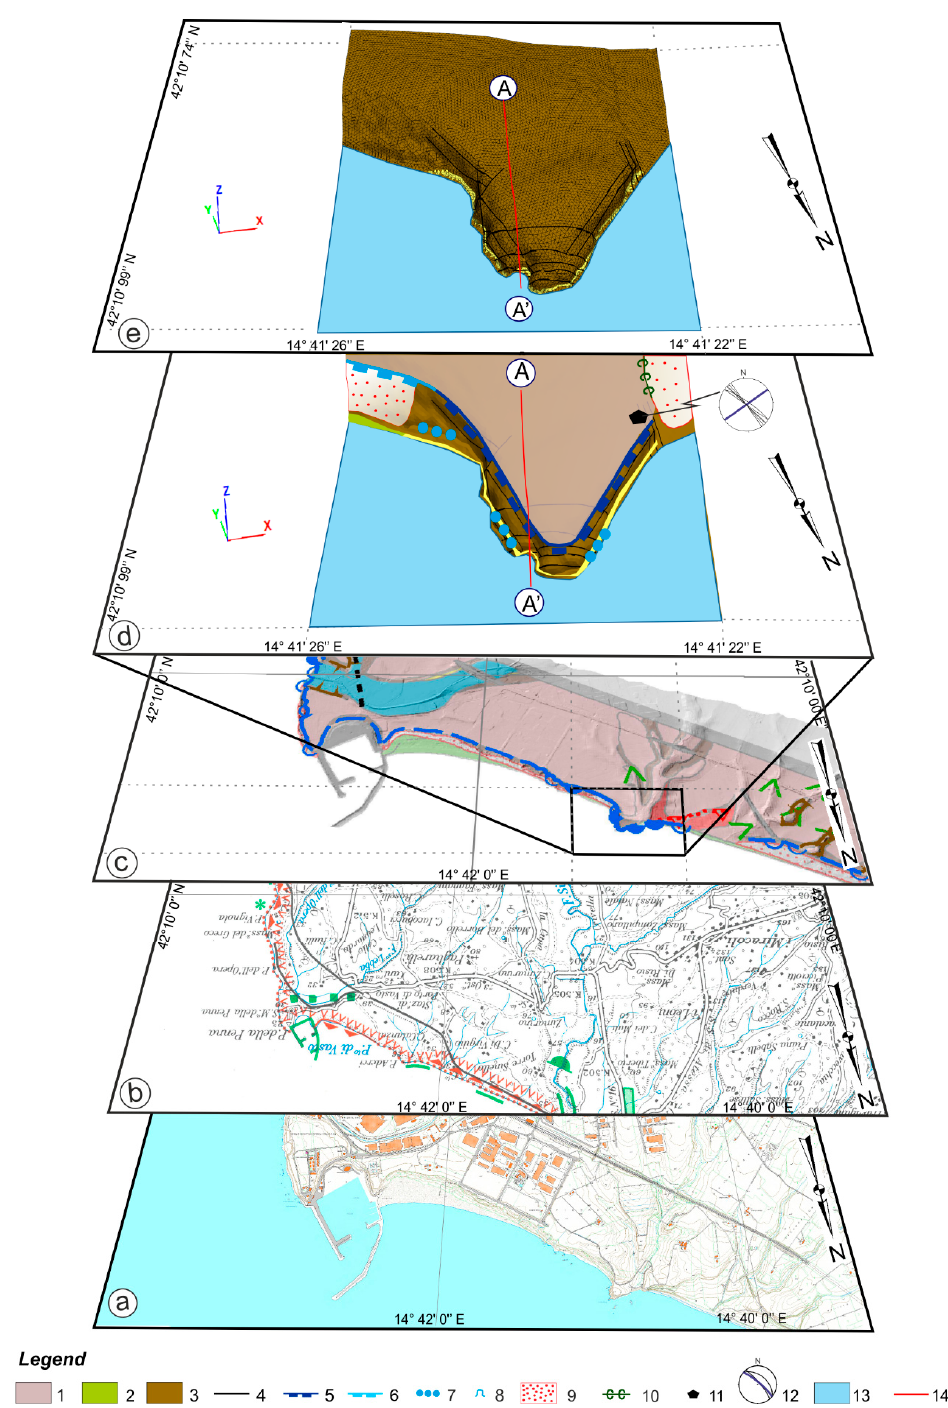
Figure 3. Methodological workflow for the reconstruction of the geological–geomorphological 3D models. ( a ) topographic map; ( b ) CNR atlas of beaches; ( c ) geomorphological map; ( d ) 3D real model; ( e ) 3D simplified model. Legend: 1. Colluvial, eluvial deposits; 2. Beach deposits; 3. Conglomerate with sandstone lenses; 4. Joint; 5. Active cliff; 6. Inactive cliff; 7. Notch; 8. Sea cave; 9. Landslide and slope deposits; 10. U-shaped valley; 11. Geomechanical station; 12. Geomechanical analysis (blue line = coastline; black line = main joints); 13. Sea; and 14. Section.